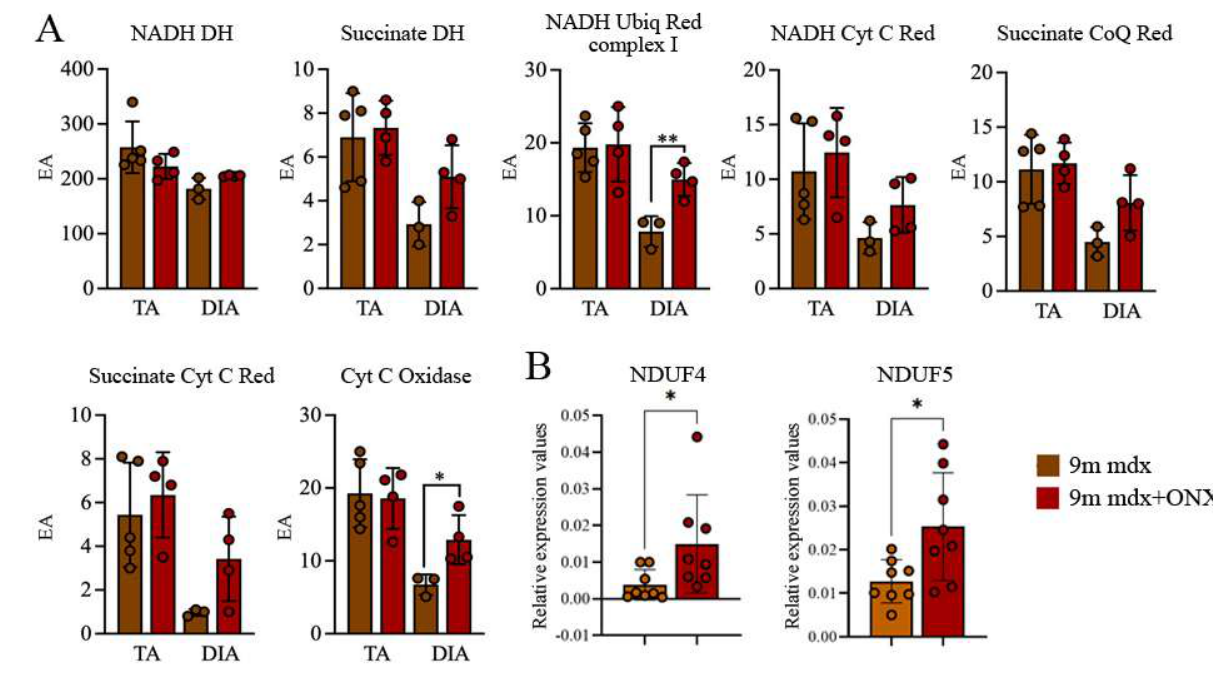
Figure 7. Mitochondrial respiratory chain enzymatic activity in TA and DIA of 9m mdx and 9m mdx+ONX mice. ( A ) Effects of ONX-0914 treatment on the activity of muscle (TA and DIA) respiratory chain enzymes in 9m mdx and 9m mdx+ONX mice (EA: enzymatic activity; NADH DH: NADH dehydrogenase; Succinate DH: succinate dehydrogenase; NADH Ubiq Red complex 1: NADH ubiquinone reductase complex 1; NADH Cyt C Red: NADH cytochrome C reductase; Succinate CoQ Red: succinate CoQ reductase; Succinate Cyt C Red: succinate cytochrome C reductase; Cyt C oxidase: cytochrome C oxidase). ( B ) RT-qPCR analysis of NDUF4 and NDUF5 in DIA of 9m mdx and 9m mdx+ONX mice. Data are expressed as means ± SD of n = 2 independent experiments with n = 4–5 9m mdx and 9m mdx+ONX mice (* p < 0.05, ** p < 0.01, with unpaired t -test). ONX-0914 upregulates NADH ubiquinone 1 reductase and of cytochrome oxidase